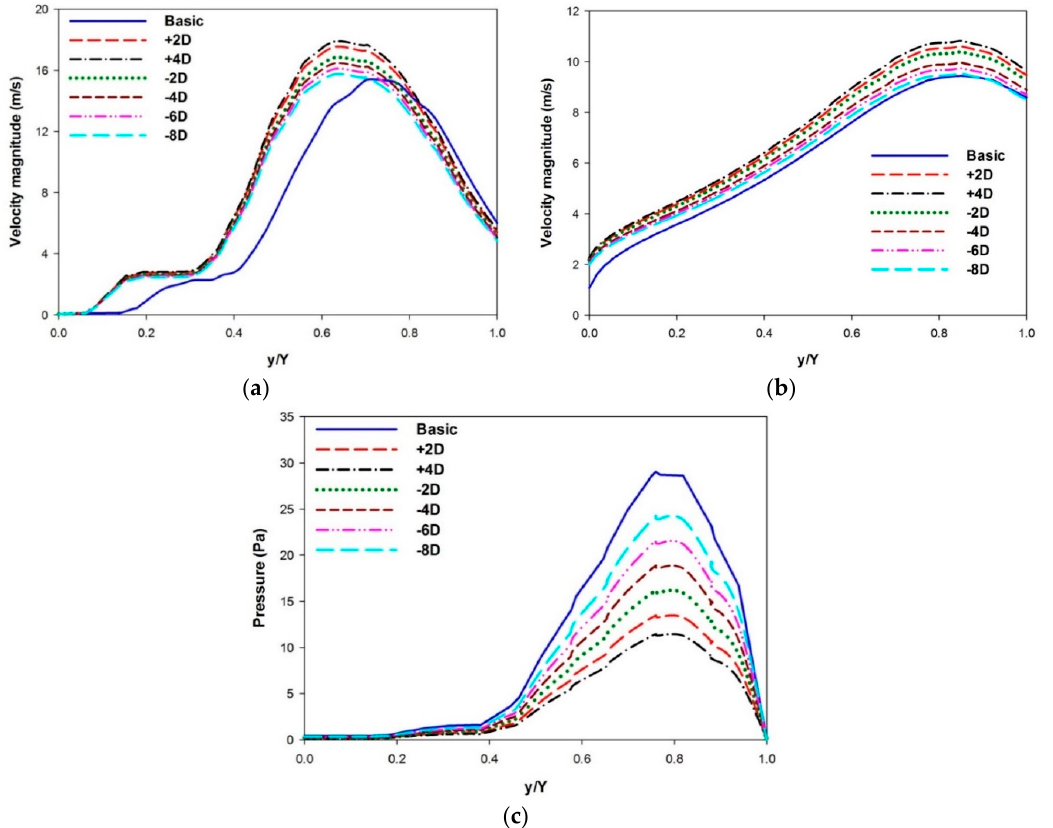
Figure 4. Effect of various duct hole diameters on ( a ) velocity magnitudes at point 1, ( b ) velocity magnitudes at point 2 and ( c ) pressure distributions at point 1 at an air inlet velocity of 35 m/s and bed slanting angle ( θ ) of